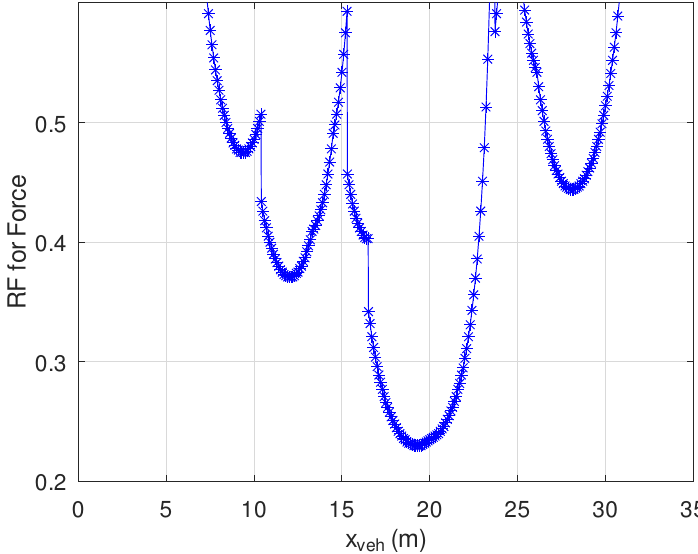
Figure 13. Rating Factor for force versus x veh for the two-span beam. Longitudinal shear in composite beams and monolithic beams with flanges can simi- larly be load rated using the interface shear flow (in kN/m) at the interface. The factored shear stress from Equation 8.4.2 of AS 5100.7 is multiplied by the width of shear plane, b f , to give this value. Similarly the shear stress capacity τ u determined using Equation